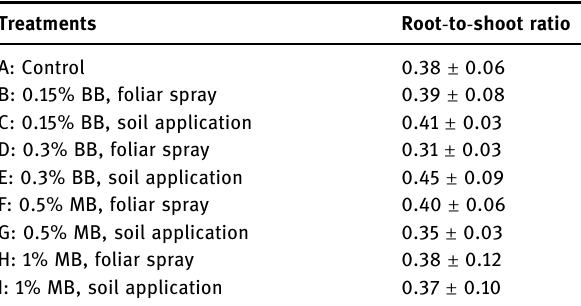
Table 3: E ff ect of biofertilizer on root - to - shoot ratio of nutmeg seedlings at 24 weeks after transplanting in the greenhouse Treatments